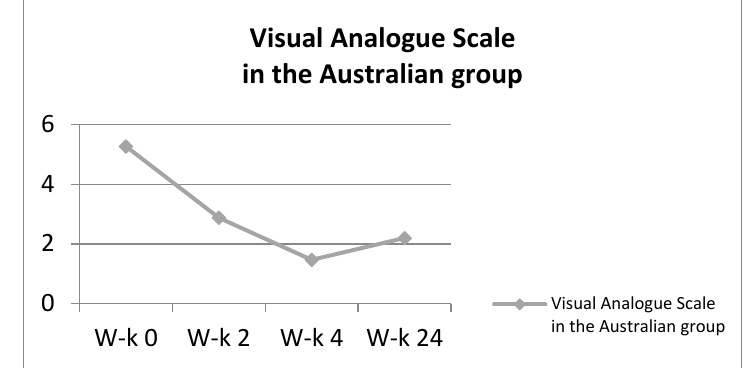
Figure 7. Visual Analogue in the Australian group.